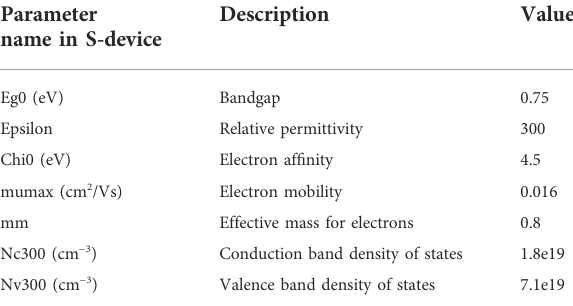
Table 1 determine the polarization component P i along the axis